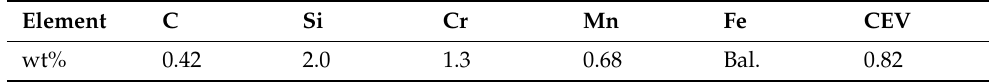
Table 1. Chemical composition and CEV of 42SiCr steel used in this work. Element